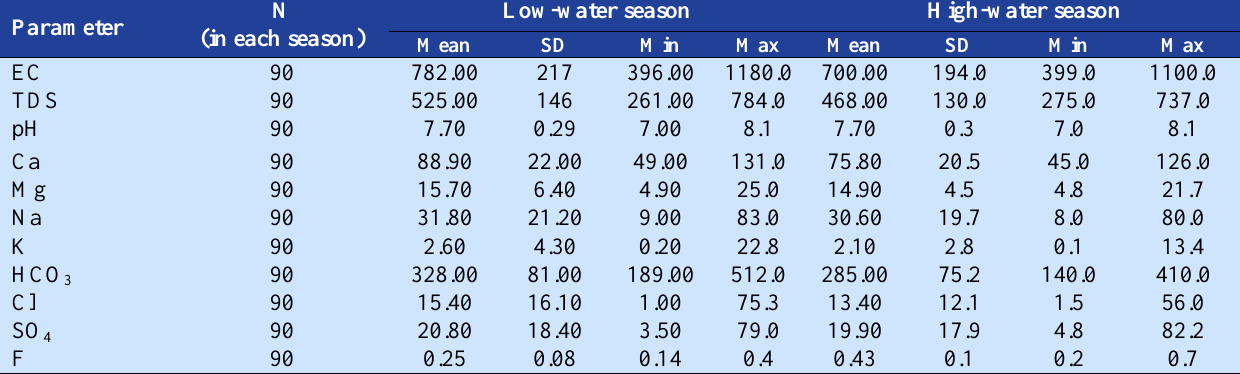
Table 2. Descriptive statistics of elemental concentration for the studied parameters Parameter